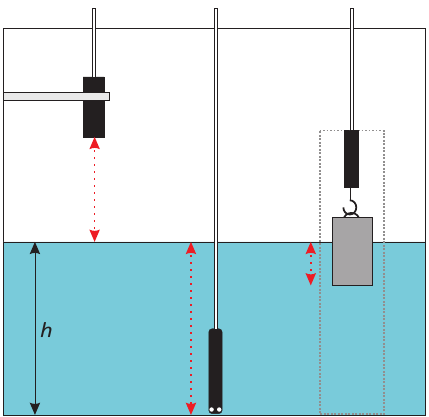
Fig. 4. Water level measurement. From left: ultrasonic probe, pressure probe, load string.